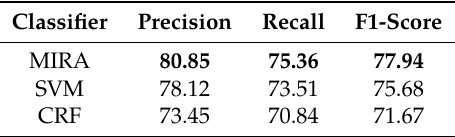
Table 8. Overall performance of each